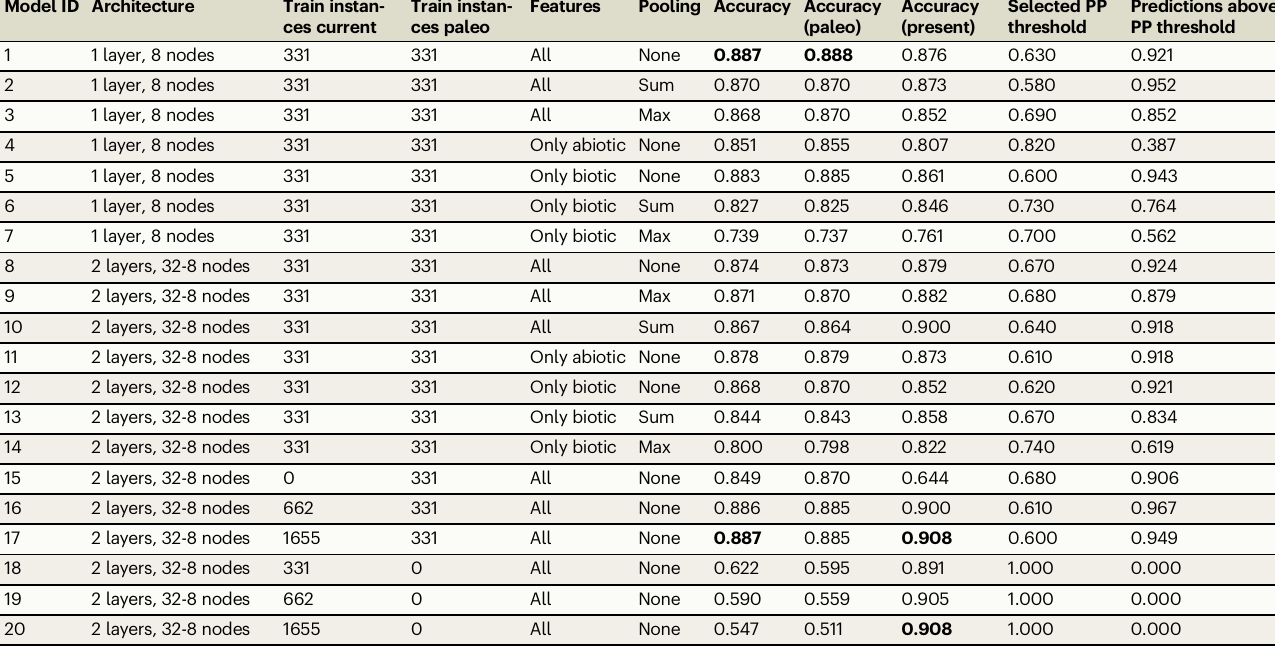
Table 1 | Prediction accuracy of tested model con fi gurations, with the accuracy of the best models highlighted in bold Model ID